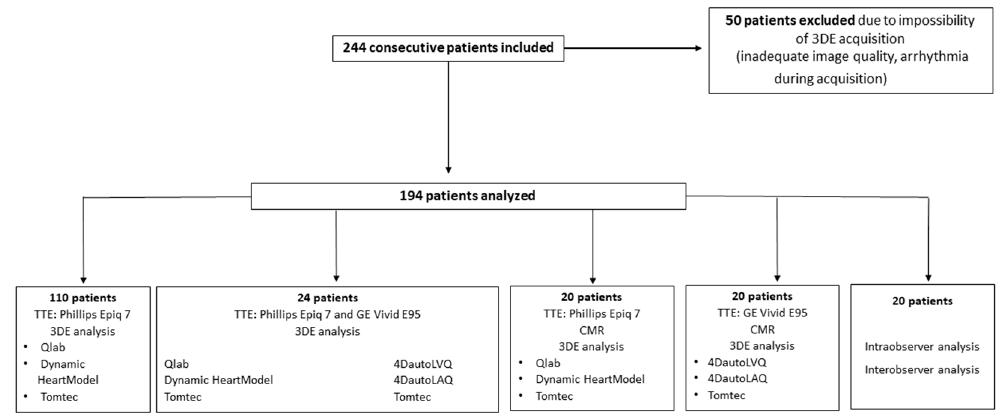
Figure 1. Study enrollment flowchart.